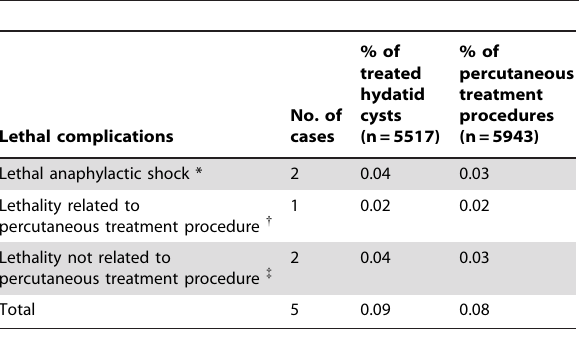
Table 2. Overall lethal complications due to percutaneous treatment of hydatid